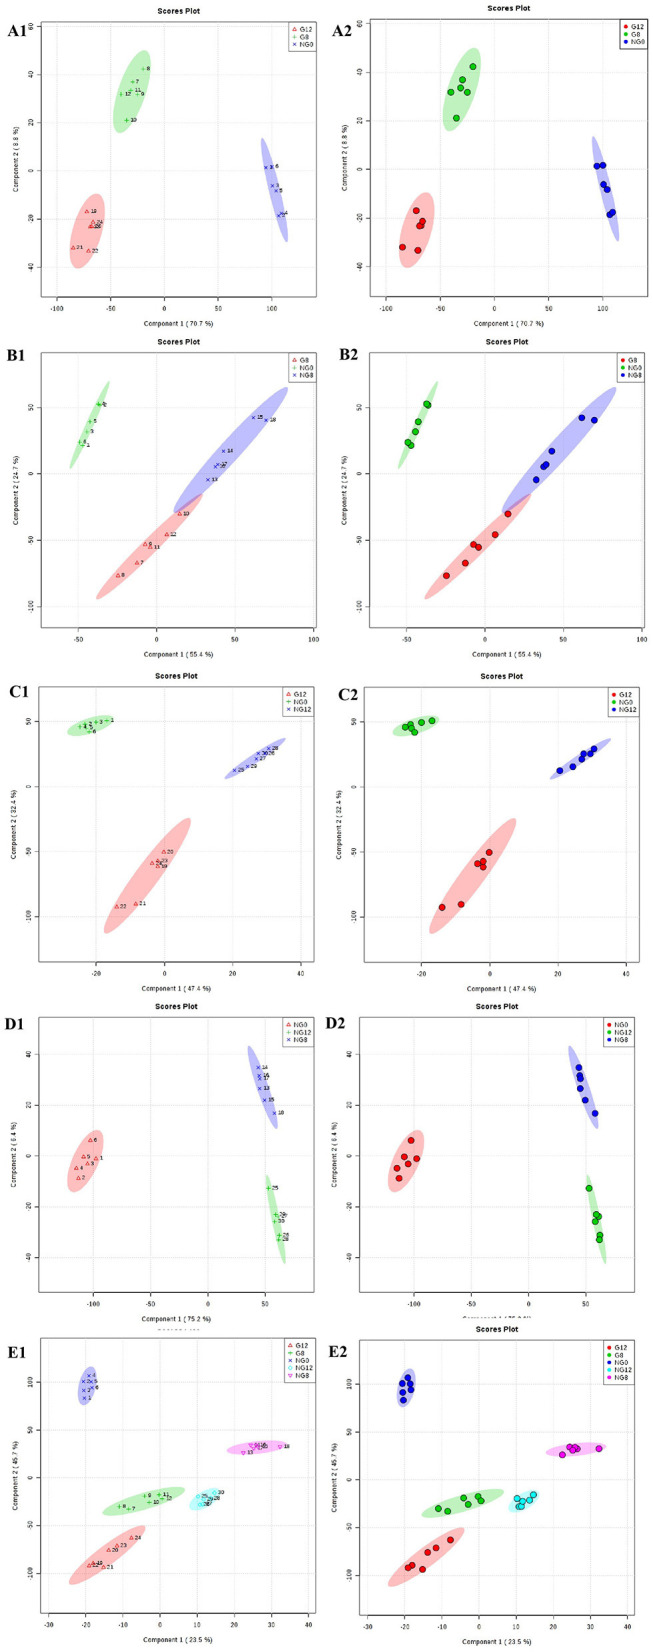
PLS-DA score plots. (A1,A2) NG0-G8-G12; (B1,B2) NG0-G8-NG8; (C1,C2) NG0-G12-NG12; (D1,D2) NG0-NG8-NG12; (E1,E2) G8-G12-NG0-NG8-NG12. The contribution rate of PC1 and PC2 in the score chart is shown. The area inside the middle ellipse represents the 95% confidence interval.